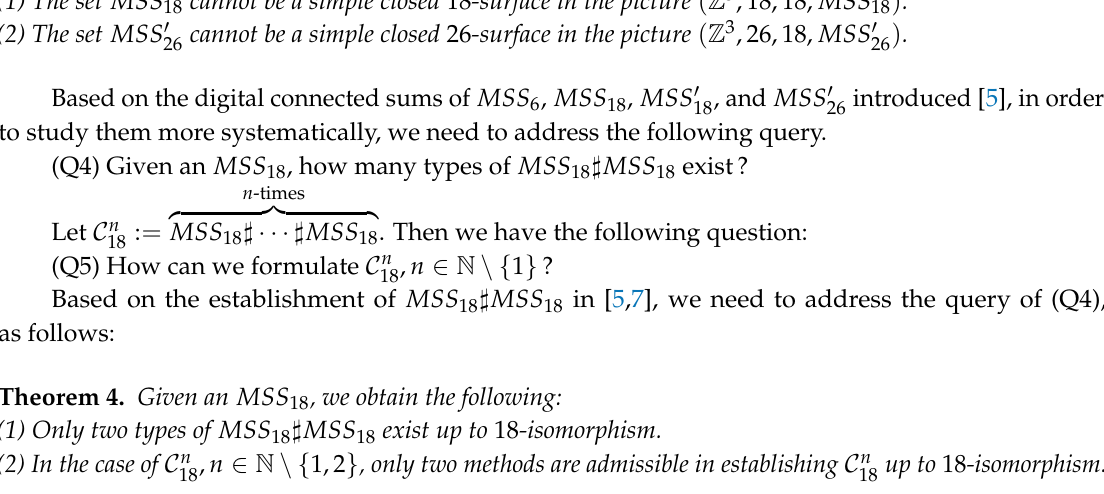
: = MSS 6 (cid:93) MSS 6 (cid:93) MSS 6 6